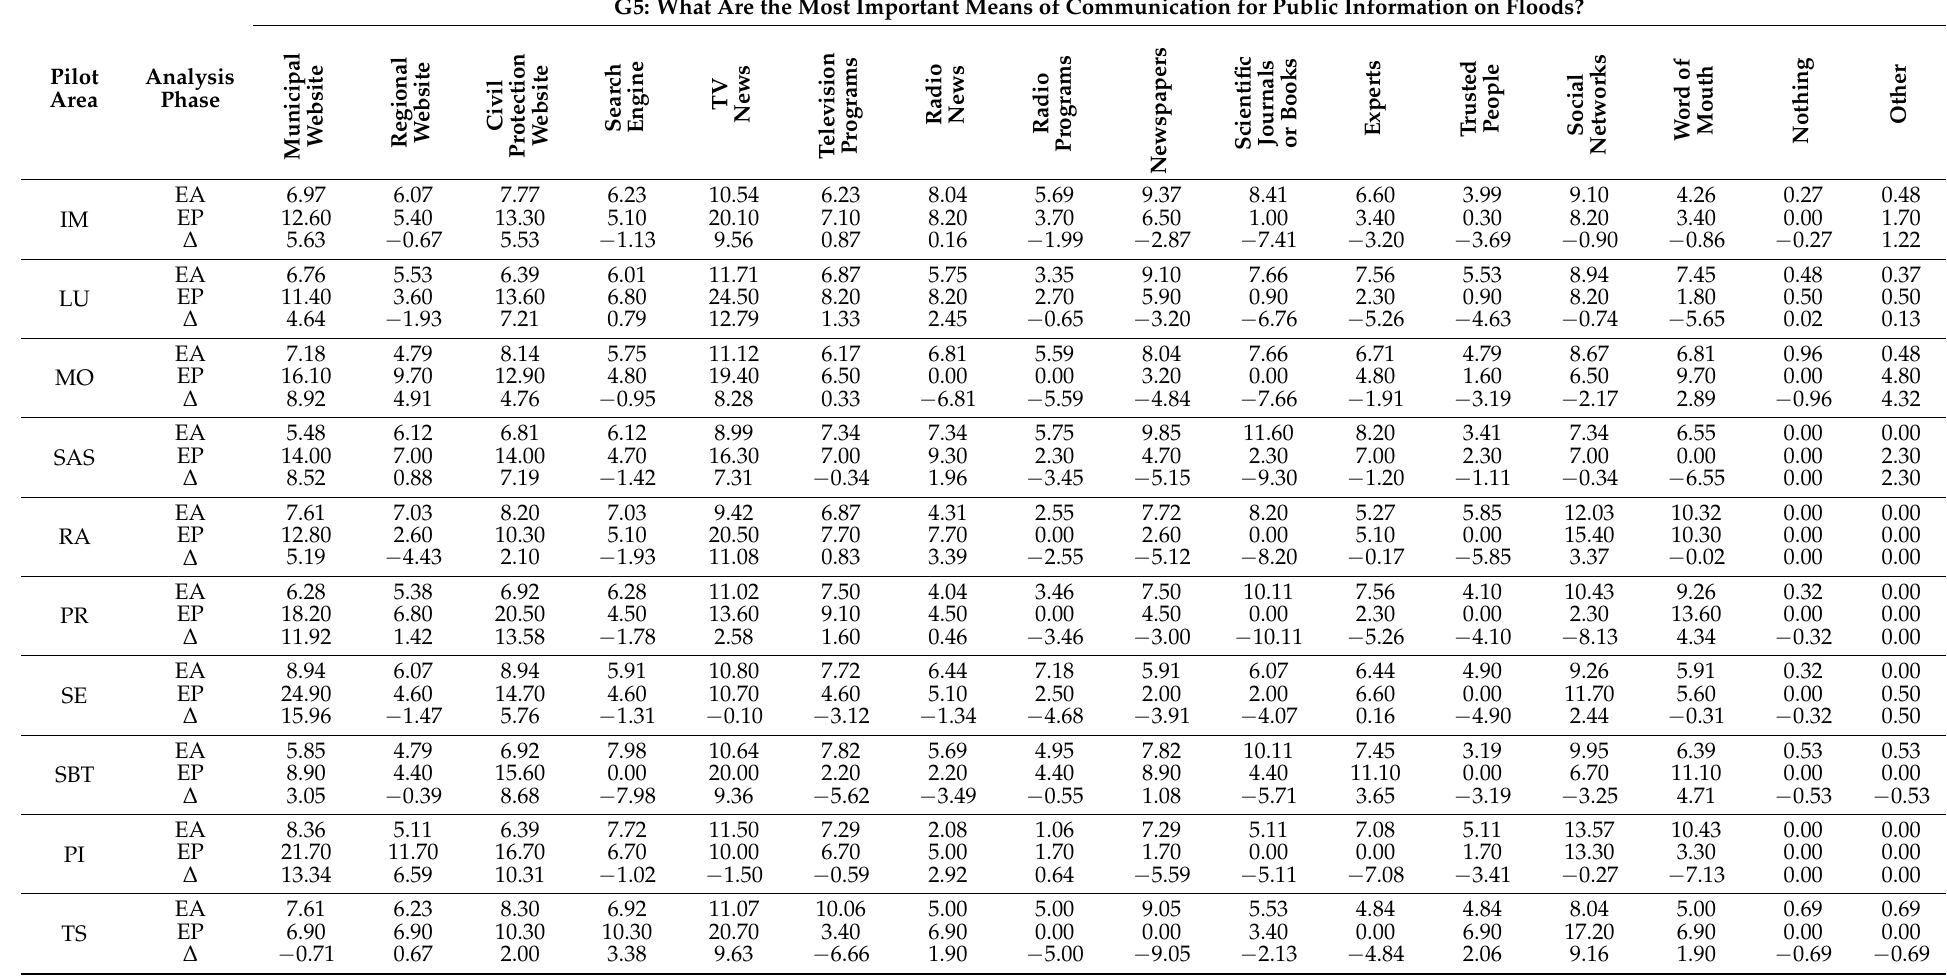
Table A6. Answers to the question G5 in percentages per each pilot area, in the ex-ante (EA) and in the ex-post (EP) phases, and their variation ( ∆